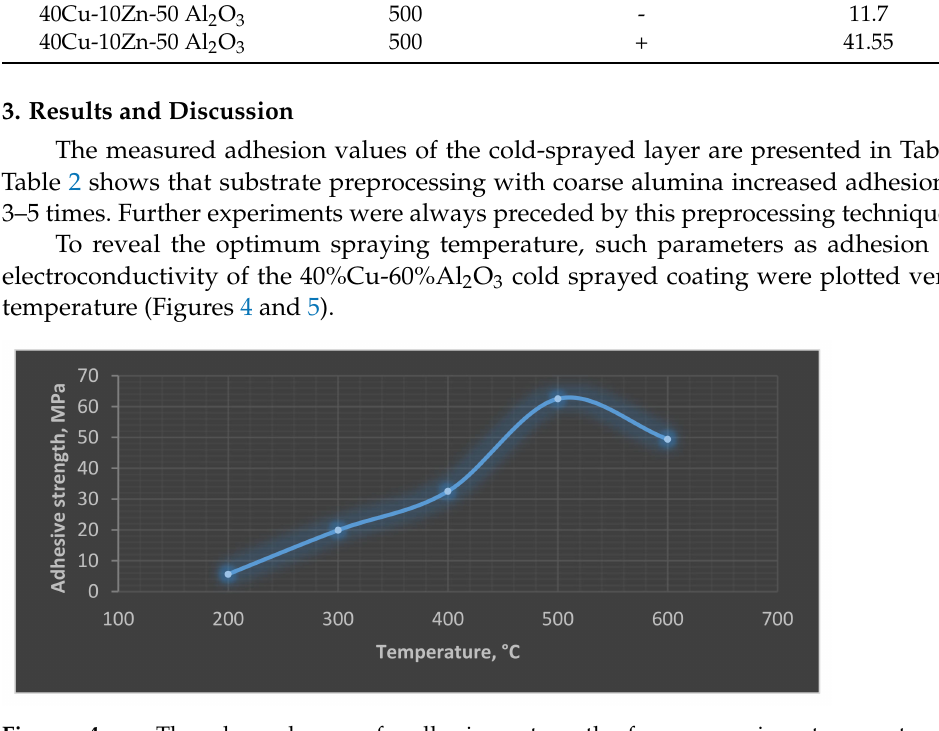
Figure 4. The dependence of adhesion strength from spraying temperature of 40%Cu-60%Al 2 O 3